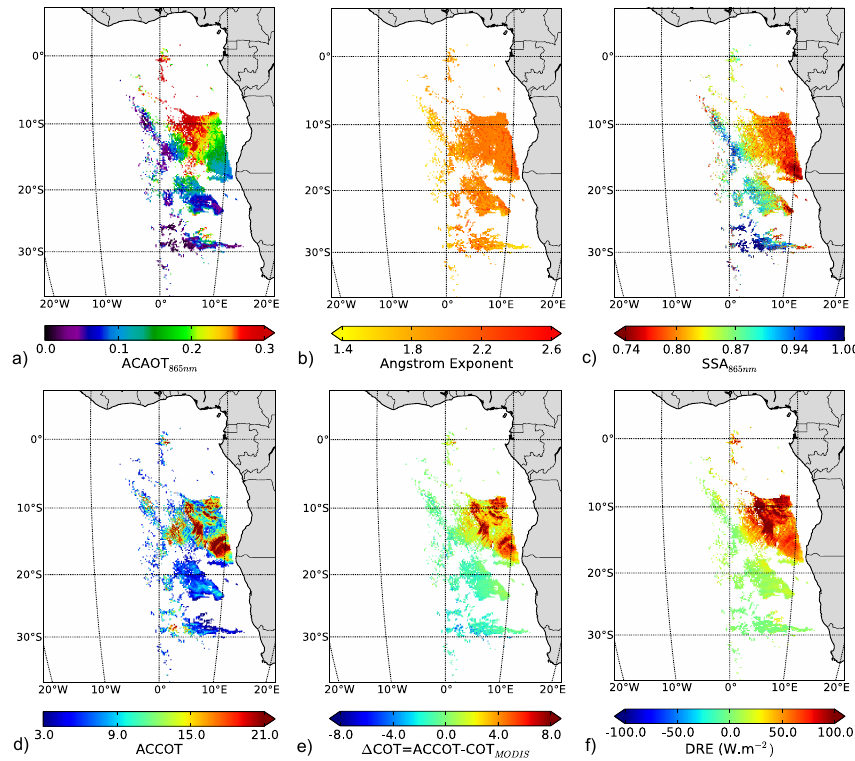
Figure 7. Biomass burning aerosols above clouds off the southwest coast of Africa on 4 August 2008. The panel displays the above-cloud AOT at 865nm (a) , the Ångström exponent (b) , the aerosol SSA at 865nm (c) , the aerosol-corrected COT at 550nm (d) , the difference (cid:49) COT of the ACCOT and the MODIS COT (e) and the DRE of aerosols above clouds in Wm − 2 (f)